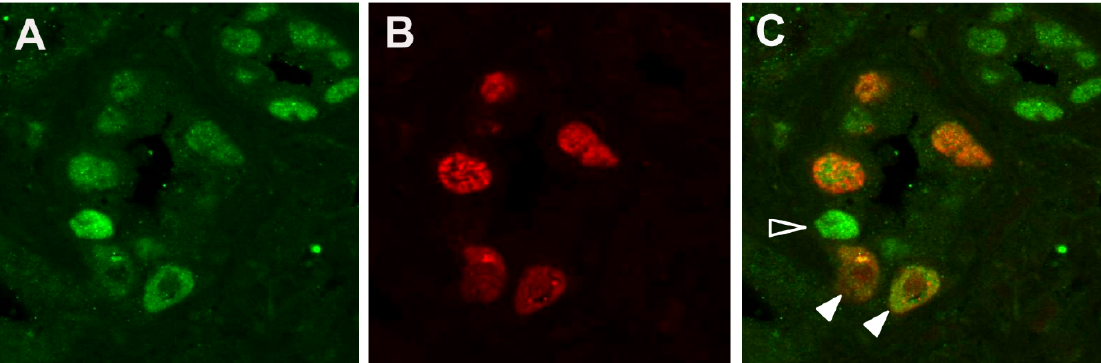
Figure 2. Dual immunofluorescent detection of a DNA damage response in virus-infected cells in PyVAN. Formalin- fixed paraffin-embedded PyVAN biopsy (stage B2). ( A ) Polyomavirus-infected tubular epithelial cells visualized by immunofluorescent staining for TAg (PAb416 and Alexa488 goat anti-mouse IgG). ( B ) Intranuclear γ H2AX in tubular epithelial cells (anti pH2AX-Ser139 and Alexa594 goat anti-rabbit IgG). ( C ) Merge of images in A and B. Open arrowhead indicates a TAg-positive, γ H2AX-negative tubular epithelial cell; filled arrowheads indicate TAg-positive, γ H2AX-positive cells with nuclear inclusions. (60 ×